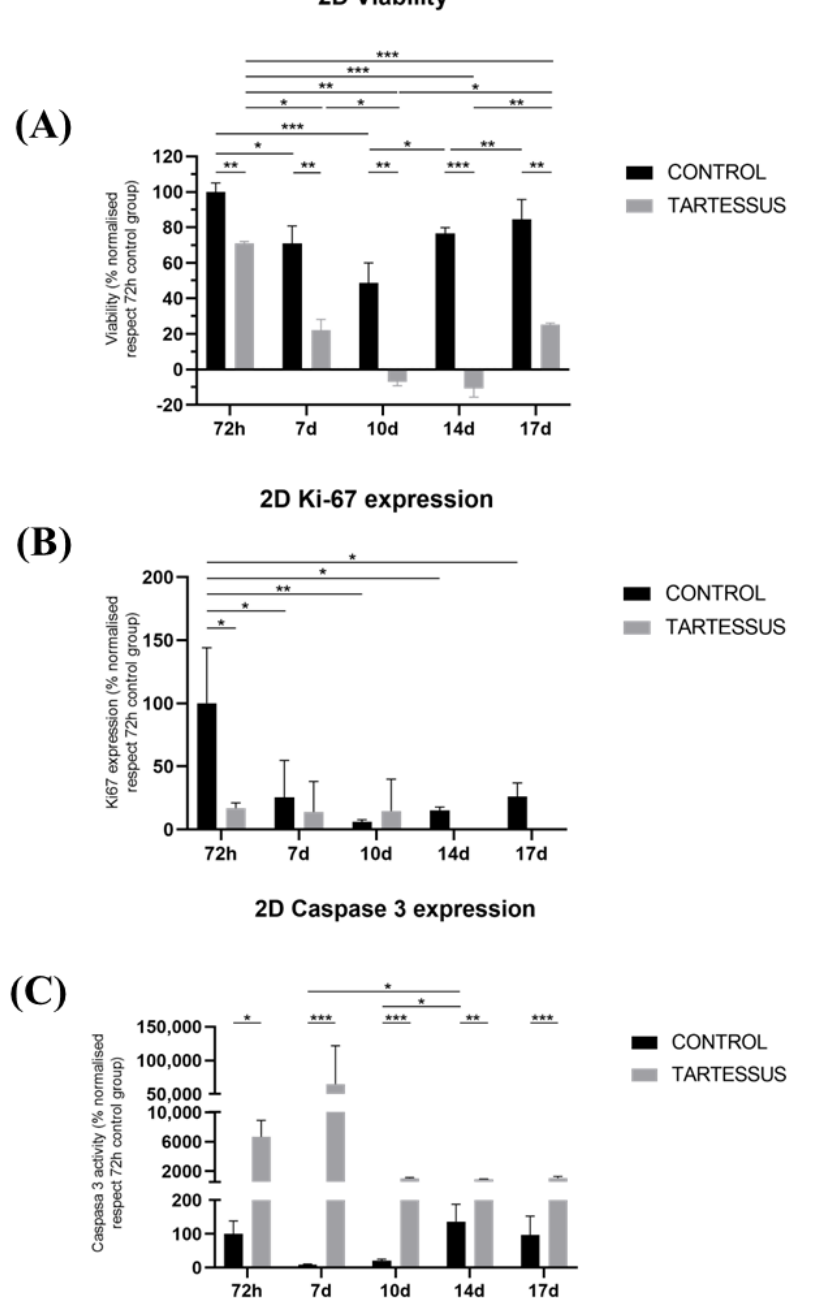
Figure 3. Experimental results obtained from 2D cultures: ( A ) cell viability, ( B ) cell proliferation measured using Ki-67 activity, and ( C ) cell death determined by the caspase 3 levels. Results are shown normalized with respect to the 72 h control group. Significant differences (*), very significant differences (**), and extremely significant differences (***).